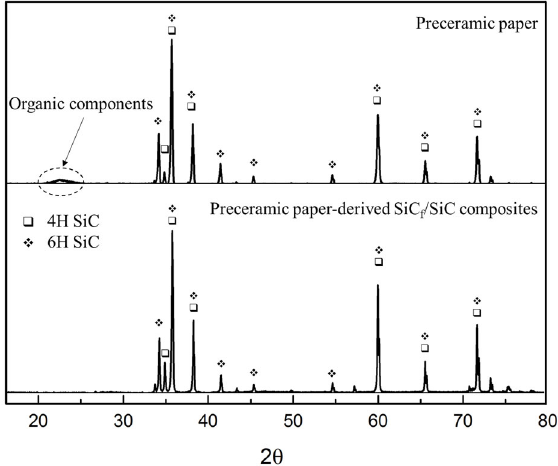
Figure 3. X ‐ ray diffractograms of preceramic paper ( upper ), preceramic paper ‐ derived SiC f /SiC Figure 3. X-ray diffractograms of preceramic paper ( upper ), preceramic paper-derived SiC f /SiC composites ( lower ). composites ( lower ). Table 1. Results of X ‐ ray diffraction analysis of the preceramic paper ‐ derived SiC f /SiC composites Table 1. Results of X-ray diffraction analysis of the preceramic paper-derived SiC f /SiC composites. Specimen Sintering Pressure